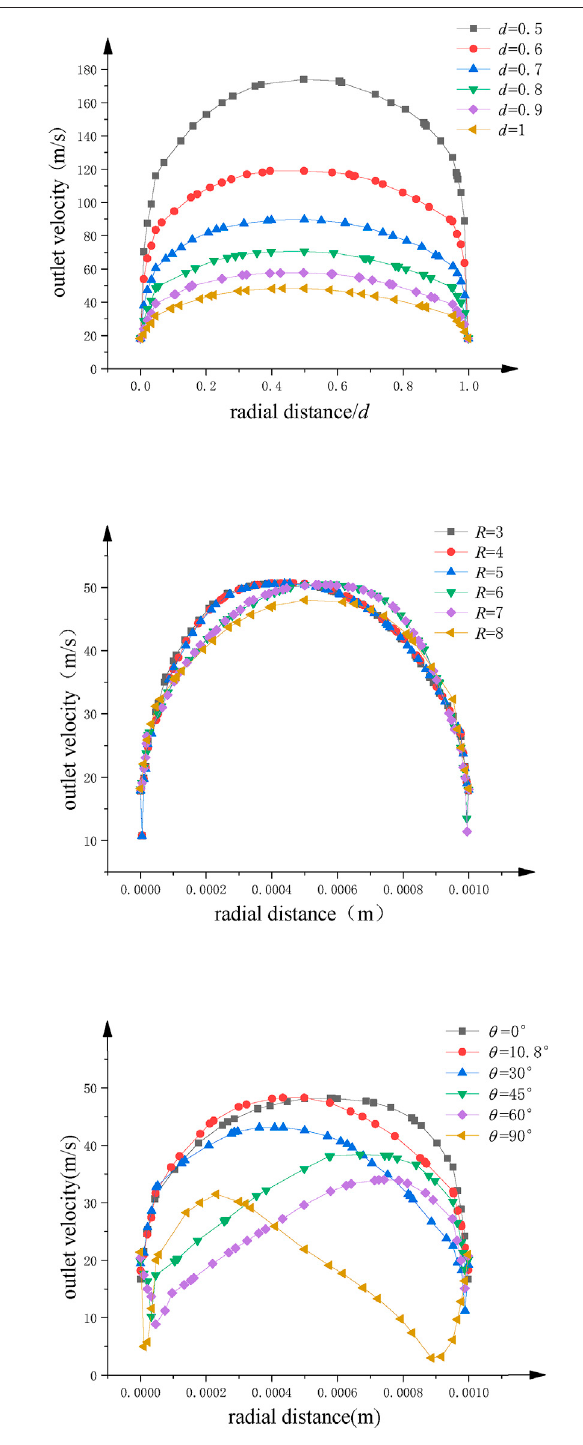
FIGURE 11 | The velocity distribution of spinning solution at outlet of nozzle. (A) Nozzle diameter. (B) Curvature radius. (C) Bending angle.